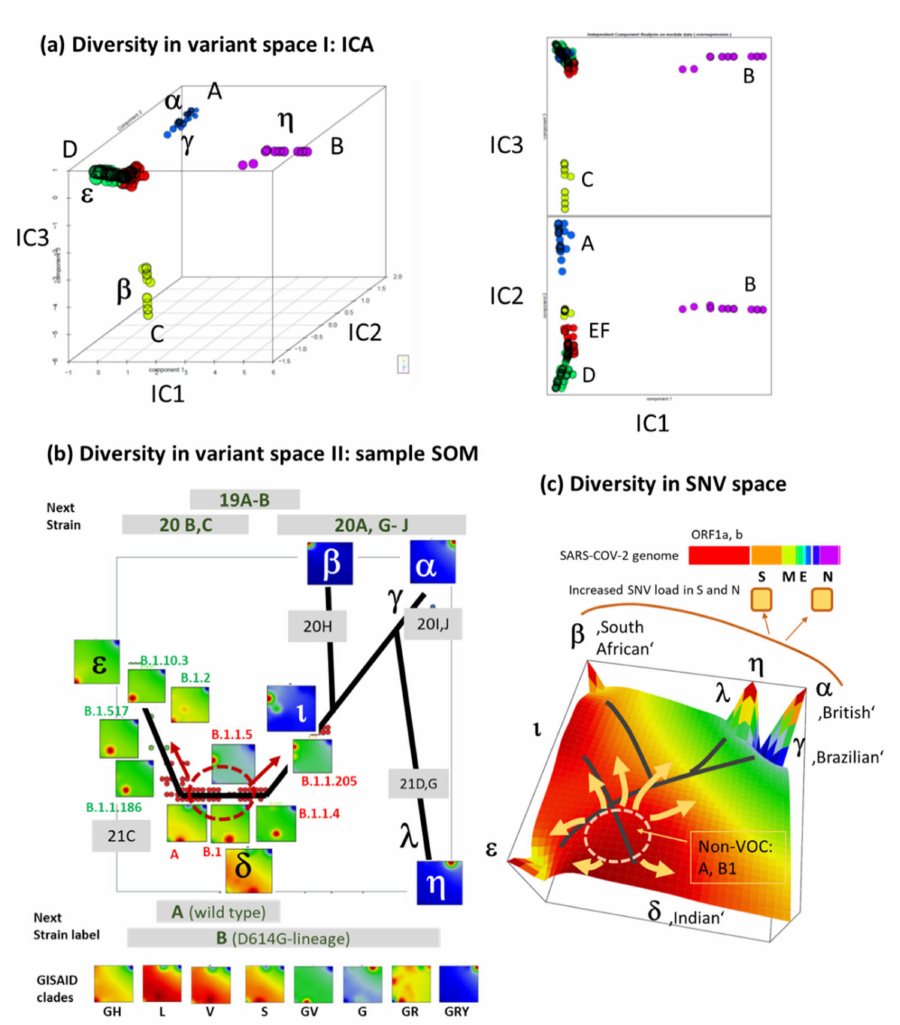
Figure 8. Similarity landscapes of SARS-CoV-2 genomes in variant and SNV space. ( a ) Independent Component Analysis (ICA) revealed that genomes of PATs A, B and C evolve each along one of the first three independent components IC1–IC2 indicating mutual independent mutational patterns. VOC gamma (‘Brazilian’ variant) is followed by alpha (‘British’ variant) along IC2. ( b ) The sample SOM distributes variants in two dimensions in non-linear scale to better resolving details of the non-VOC root areas of SARS-CoV-2 evolution. Early SARS-CoV-2 variants (GISAID clades L, V, S) locate in the center (red ellipse). Development proceeded towards PAT D to the left and A, B, C to the right. PATs A–D refer to VOCs/VOIs as indicated in part a of the figure. The tree (black lines) is adapted from Figure 4b. NextStrain nomenclature is indicated using grey background, where A-labeled clades refer to the early detected ones. The number indicates the year of first report and the letter is the count of variants reported, e.g., 20H assigns the South African variant B.1.1351 as detected in 2020 just before the Brazilian (20I) and British (20J) ones. Spike-protein substitutions D614G